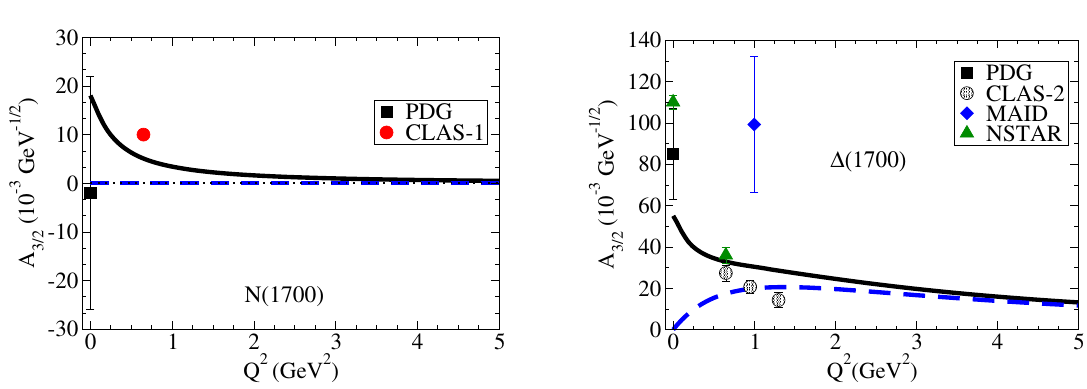
Figure 7. Examples of estimates of amplitudes associated with negative parity states based on the single quark transition model [23]. The solid line represent a model where the meson cloud e ff ects are taken into account. Check [23] for the description of the